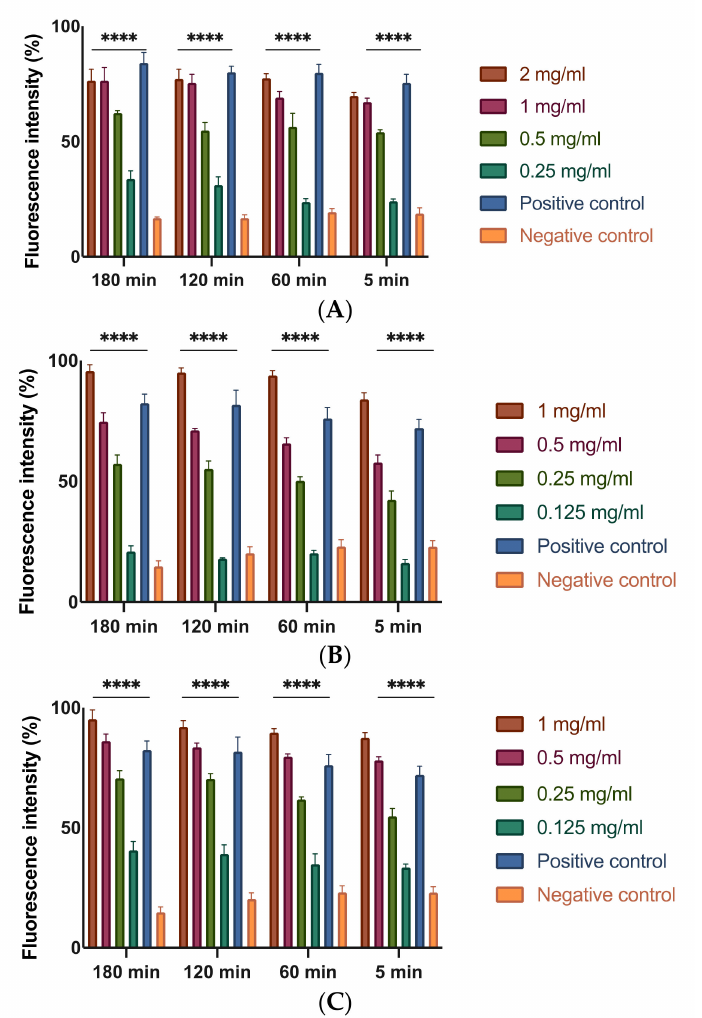
Figure 1. Effects on membrane permeability: ( A ) HA-MOE; ( B ) MeOH-MOE; ( C ) HAMD-MOE. The graph shows the loss of membrane integrity by the increase in fluorescence intensity in the treated samples. Data are the mean of 3 independent experiments performed on triplicate (mean +/ − standard deviation), and values are represented as a percentage; **** p -values <